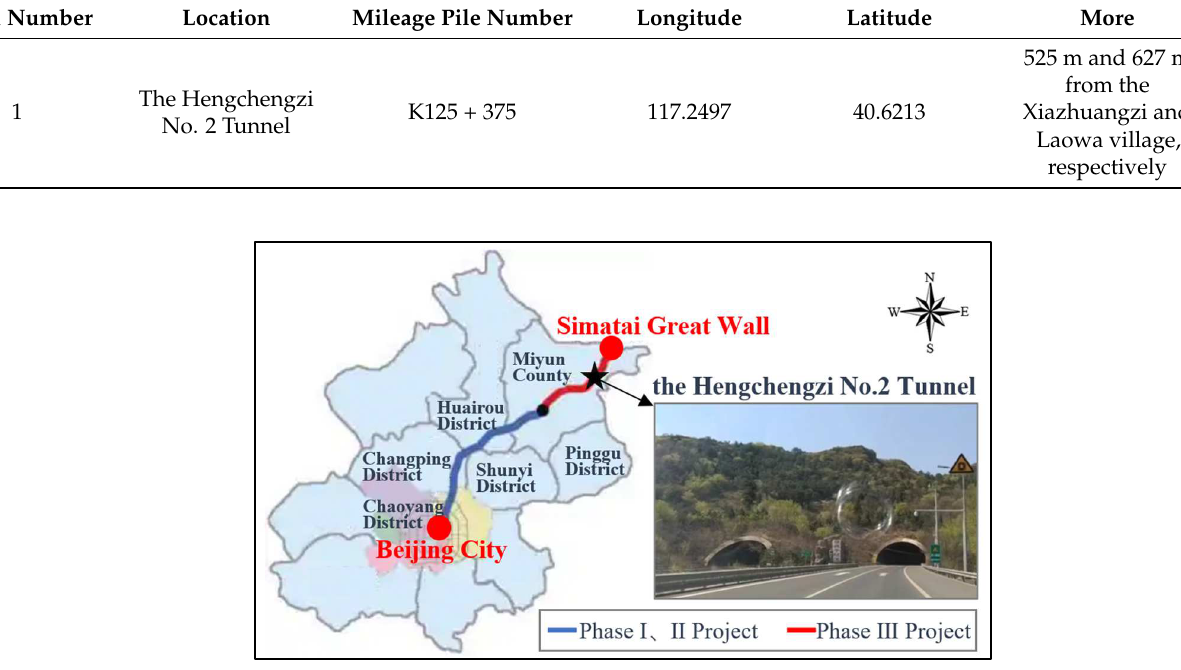
Figure 2. The map of a typical section and the main control points of the study case.